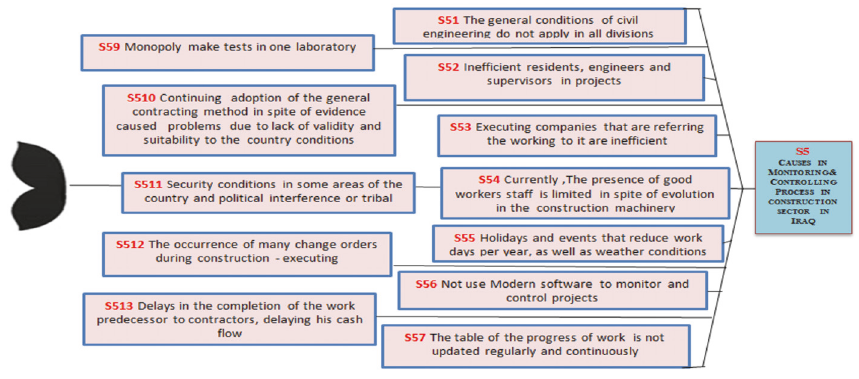
Figure 11: Fishbone diagram for project executing and monitoring management process group.